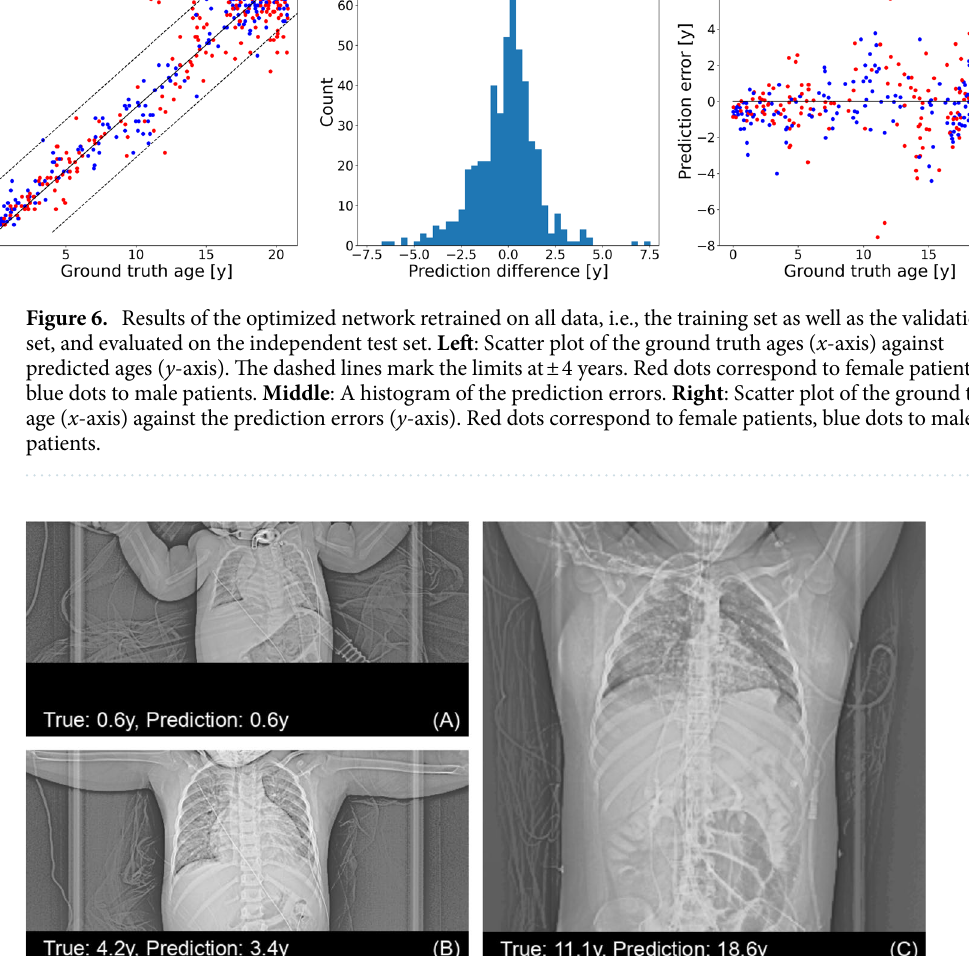
Figure 7. Three scout views from the test set, where the prediction error of the optimized network was ( A ) near zero, ( B ) near the median error, and ( C ) worst over all scout views. Scout views were cropped to increase visibility. Note that in ( C ) a pulmonary ground glass opacity can be seen, possibly due to